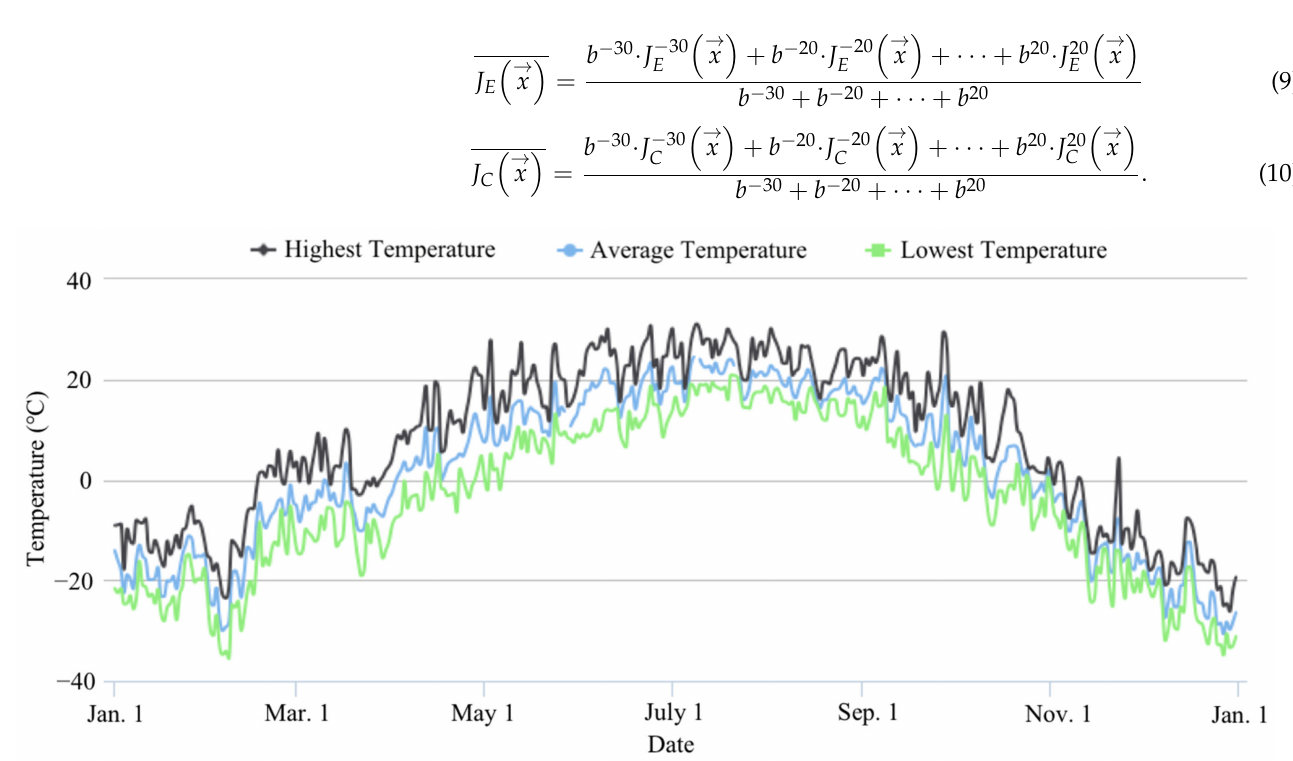
Figure 19. Annual ambient temperature of Heihe, China in 2019